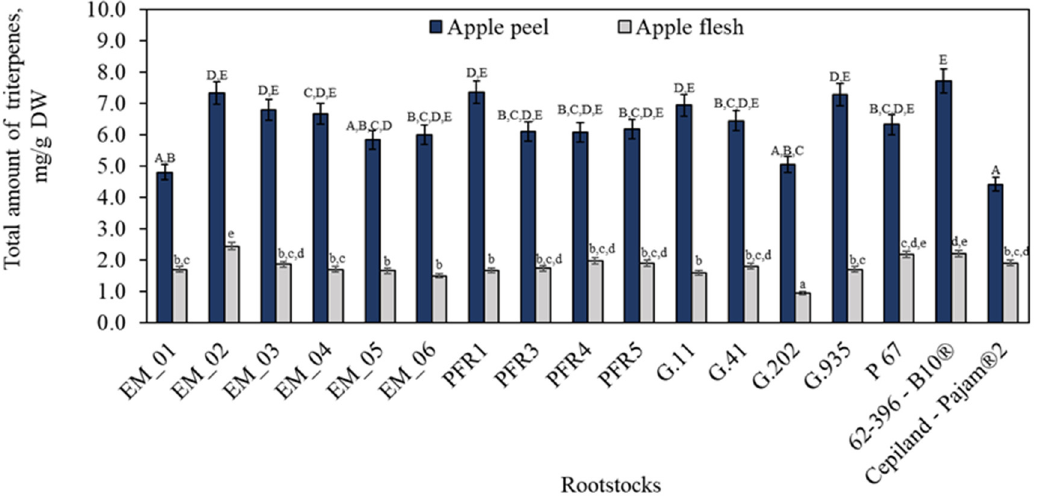
Figure 1. Influence of rootstocks on the quantitative composition of triterpene compounds. The means followed by different uppercase and lowercase letters are significantly different at p < 0.05.